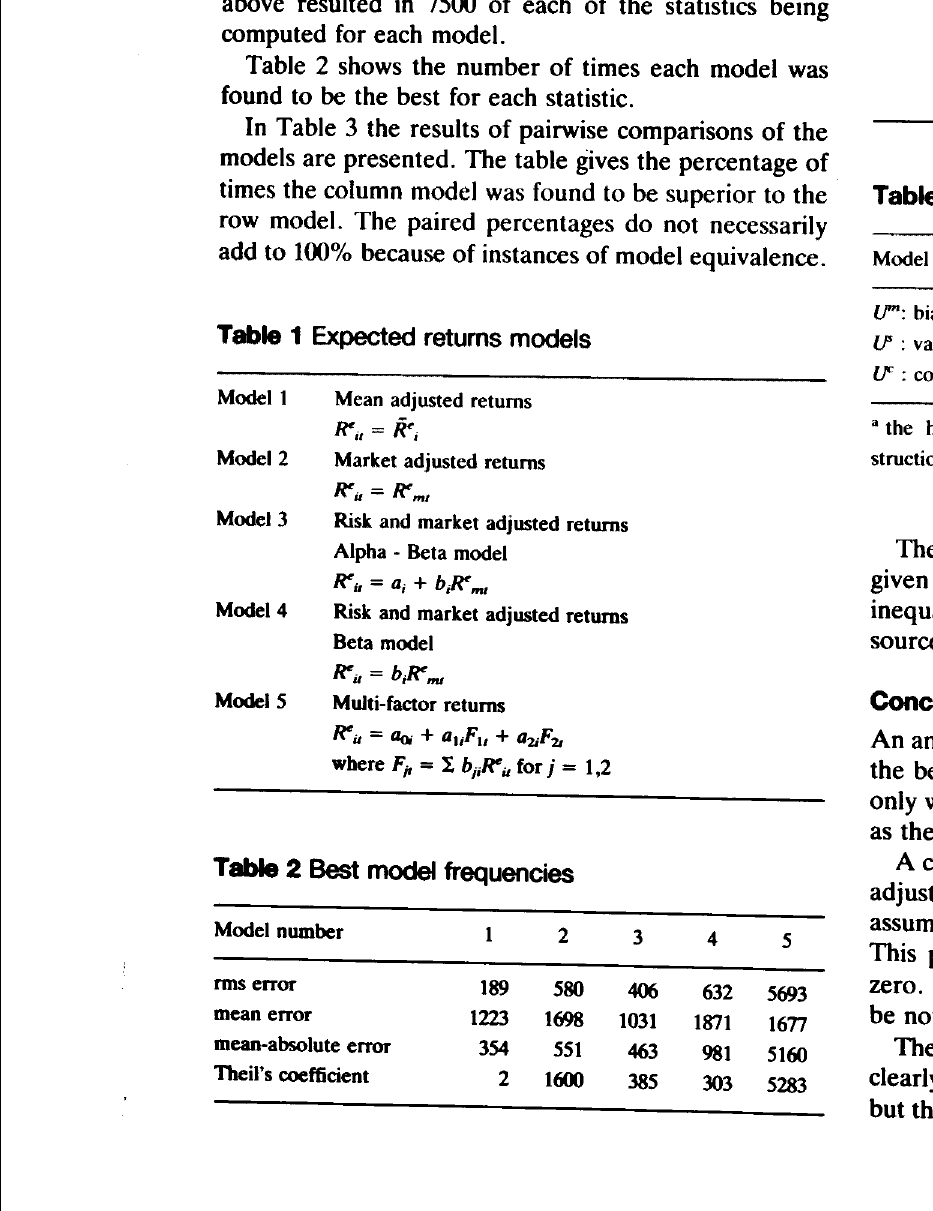
Table 4 Theil's proportions of